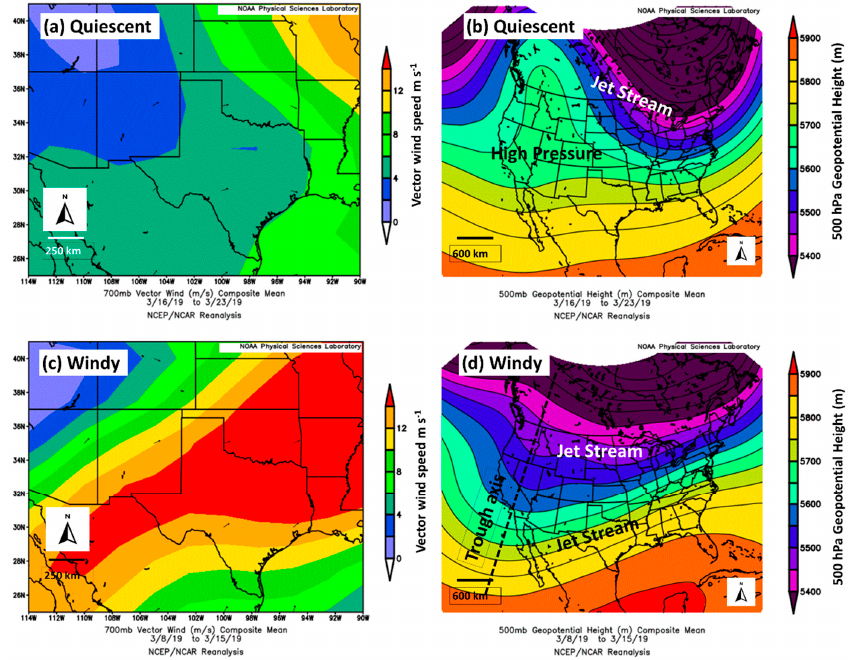
Figure 5. National Centers for Environmental Prediction (NCEP) NCEP/NCAR reanalysis of 700 hPa winds and 500 hPa geopotential heights for: ( a ) 700 hPa winds 16–23 March 2019 (quiescent); ( b ) 500 hPa geopotential heights from 16–23 March 2019 (quiescent); ( c ) 700 hPa winds 8–15 March 2019 (windy); and ( d ) 500 hPa geopotential heights 8–15 March 2019 (windy). Image composites were produced by the National Oceanic and Atmospheric Administration (NOAA) Phys- ical Sciences Laboratory at their website https://www.psl.noaa.gov/data/composites/day/ (accessed on 14 February 2021). The meteorological conditions across the Permian Basin during the windy short-term case study period (8–15 March 2019) were characterized by the slow passage of a large low pressure system and associated jet stream over the western USA at 500 hPa, while average 700 hPa wind speeds were between 12 and 16 m s − 1 (Figure 5c,d). At the surface, westerly flow greater than 10 m s − 1 was noted over much of the eight-day period at Dun- kin, on the western slopes of the Sacramento Mountains, while periods of westerly winds over 10 m s − 1 were frequently noted in the Pecos River Valley (at Carlsbad) (Figure S1).